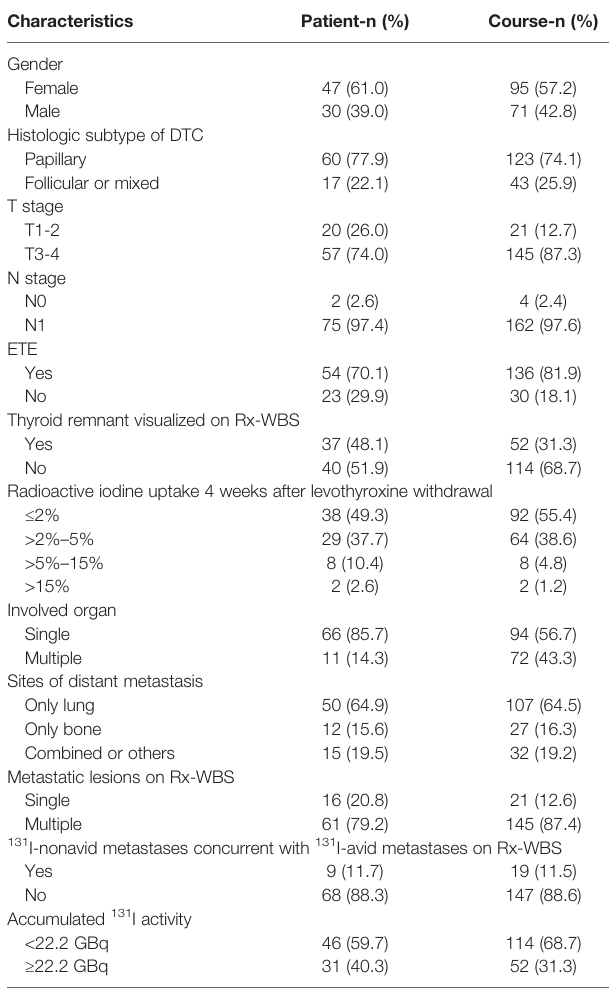
TABLE 1 | Categorical clinicopathological characteristics of eligible former 131 I therapeutic courses (N = 166) from 77 patients.